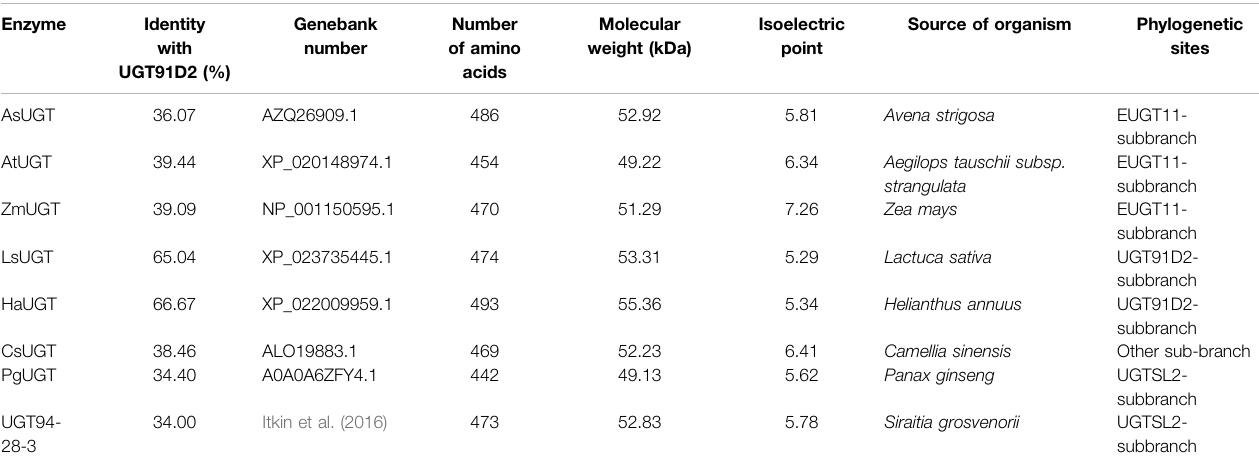
Isoelectric Source of organism Phylogenetic point